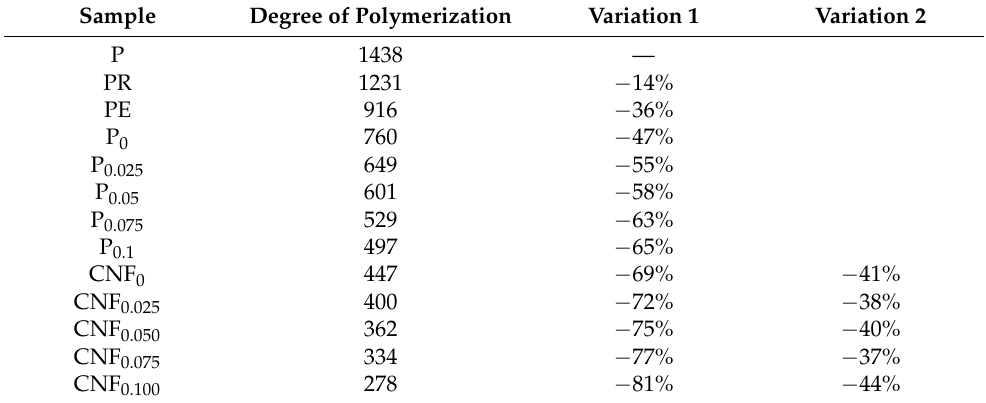
Table 3. Variation in the degree of polymerization depending on the treatment